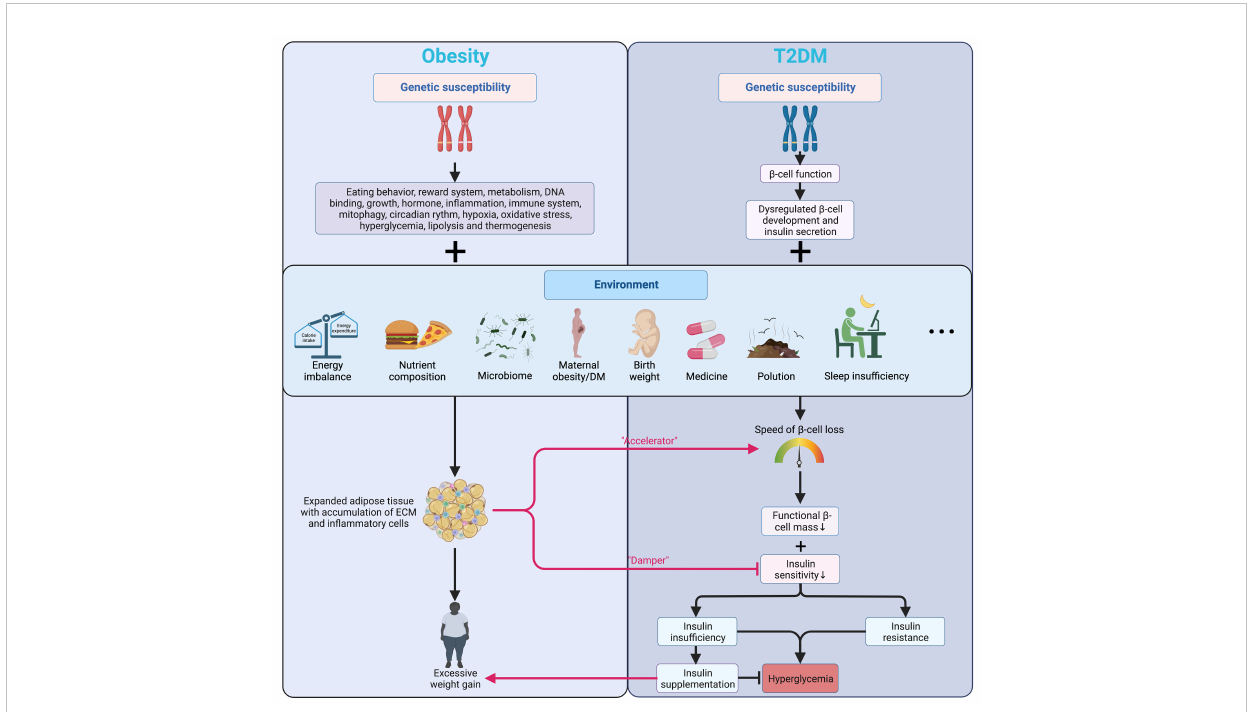
FIGURE 1 Genetic and environmental factors affecting islet function and connecting obesity and T2DM. Genetic factors mainly alter the energy balance in obesity while regulating the development and function of b -cells in T2DM. Being further promoted by various environmental factors, obesity accelerates the b -cell loss and blunts insulin signaling in T2DM. Meanwhile, insulin prescribed to patients with T2DM can have a weight-increasing effect. Arrows in color indicate the interactions between obesity and T2DM. T2DM, type 2 diabetes mellitus; ECM, extracellular